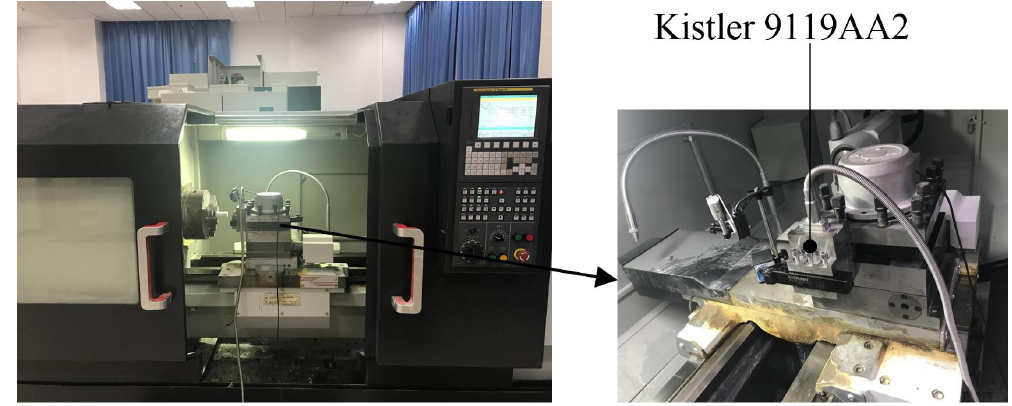
Figure 7. Turning experiment and cutting force test site.